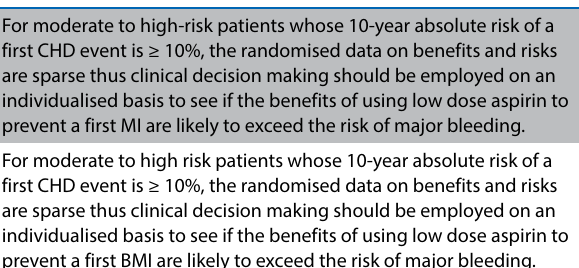
Table 12: A pragmatic evidence-based approach to the prescription of Aspirin as primary prevention using the patient’s Framingham score.